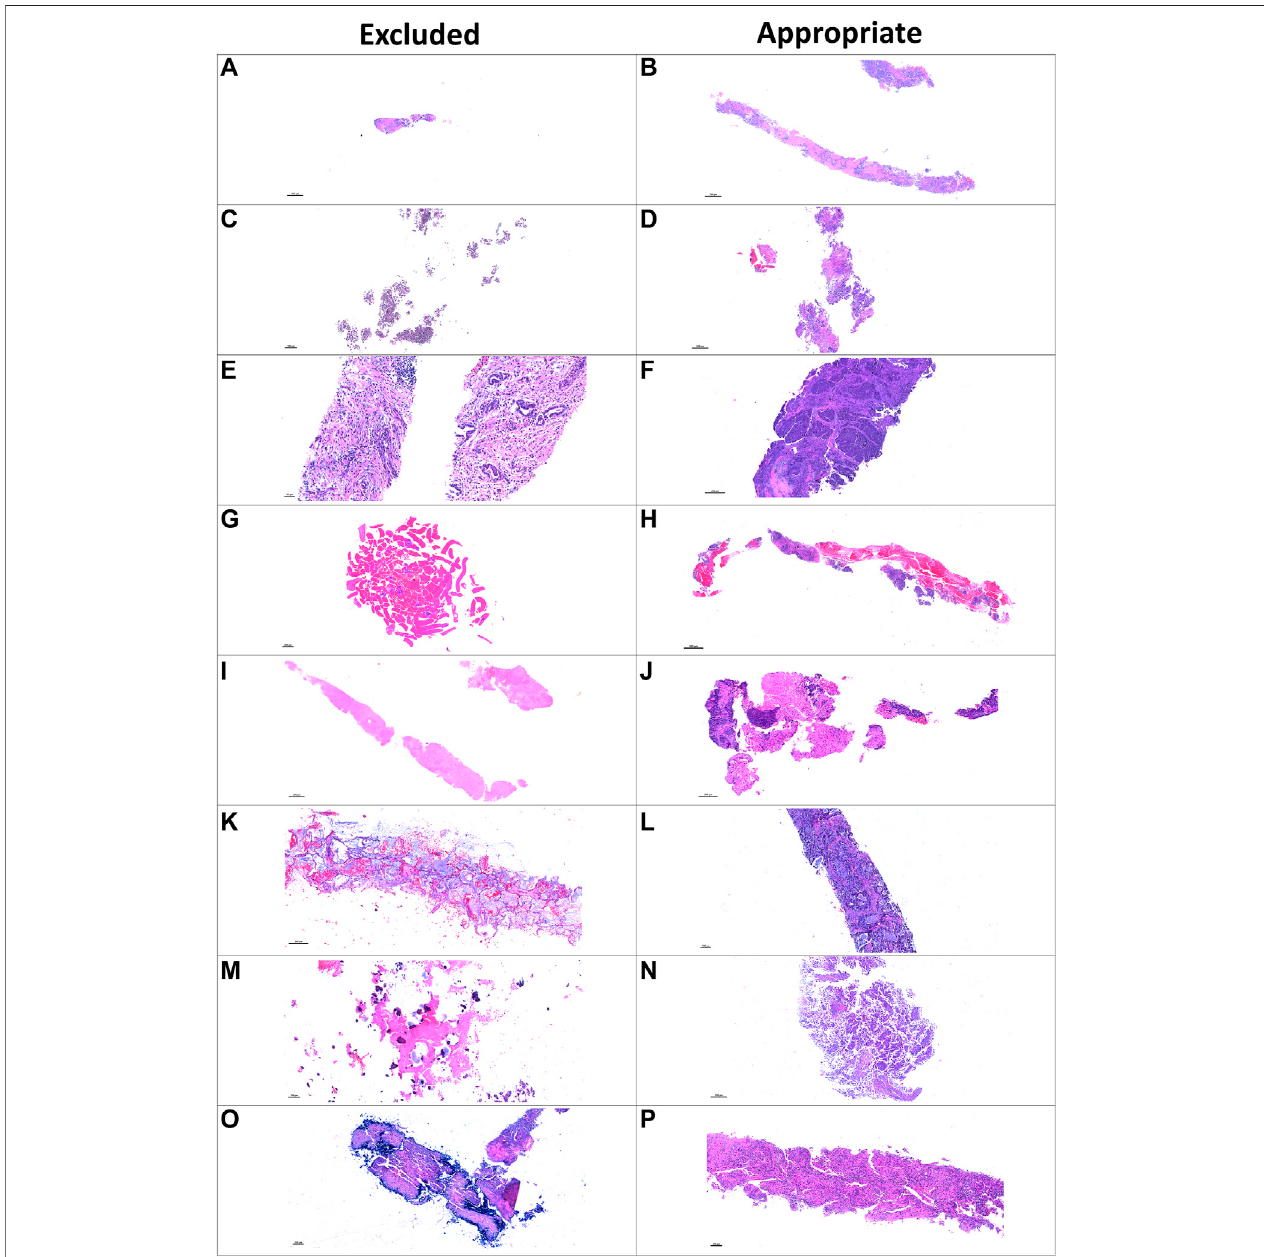
FIGURE3 | Microphotographsofrepresentative examples ofexcluded and included core needle biopsies using hematoxylin and eosin slides forpathology quality control.Excludedexamples( leftcolumn )comparedwithsamplesconsideredappropriateforimageanalysis( rightcolumn ).Smallsamplesize (A) comparedwithalarge, adequatesample (B) .Samplewithoutmalignantcellsandonlywithnormaltissue (C) comparedwithasamplewithadequateamountofmalignantcells (D) .Samplewith extensivefragmentation (E) comparedwithanotherfragmentedsamplethatcouldbeincludedintheanalysis (F) .Smallsamplewithextensivehemorrhagicarea (G) compared with another large sample with extensive hemorrhagic area but also with enough tumor content (H) . Sample with extensive necrotic area (I) compared with another similarly sized sample with enough tumor content for analysis (J) . Sample with mucinousand scattered malignantcells (K) compared with asample considered appropriate for image analysis (L) . Sample with predominant fi brosis and calci fi cation (M) compared with an adequate tumor-containing sample (N) . A biopsy with artifact of desiccation (O) compared with a well-preserved biopsy (P) .